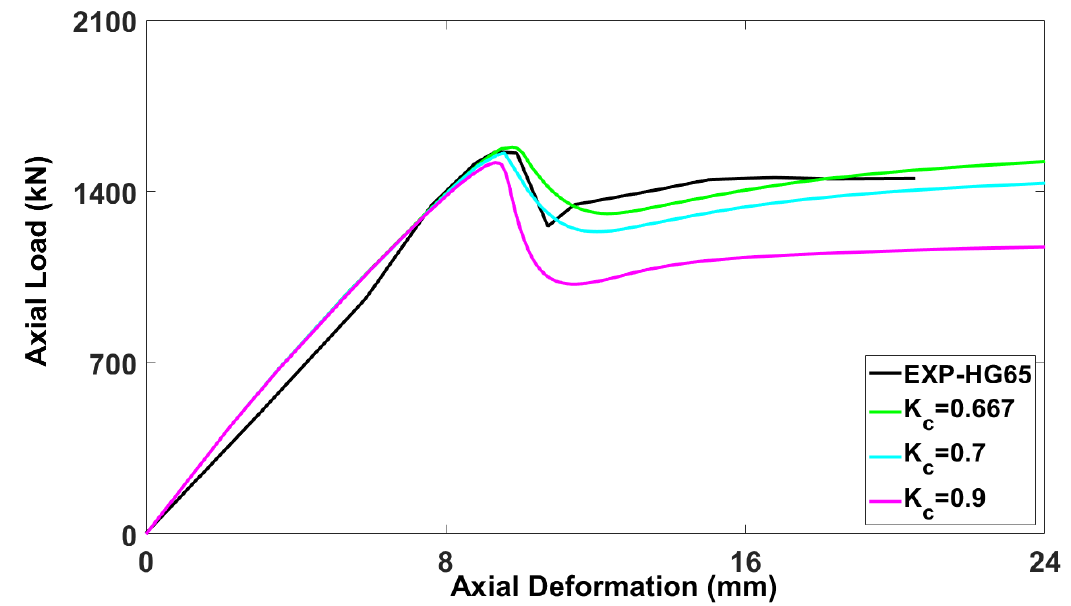
Figure 9. Calibration of control specimen (HG-65) for shape factor.